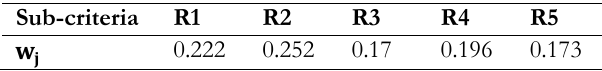
Table 18. The weight of the sub-criteria after sorting.